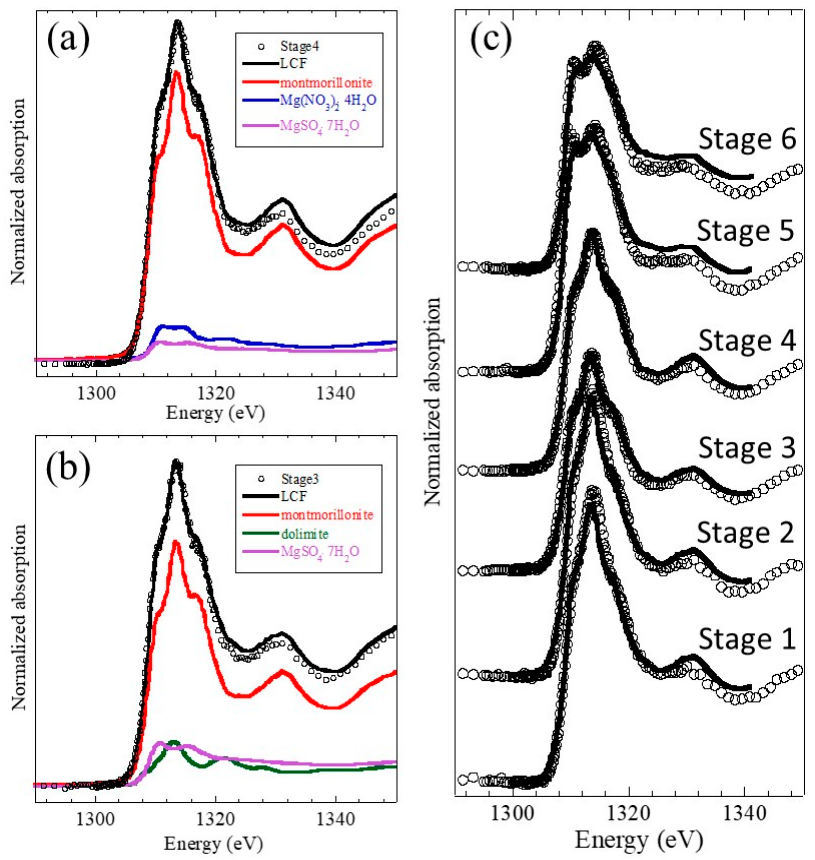
Figure 7. Mg K-edge XANES spectra for Mg in aerosol samples: ( a ) LCF for Mg in ( a ) Stage 4 and ( b ) Stage 3. ( c ) LCF results for XANES spectra of aerosol particles (circle: measured spectra; solid curve: fitted spectra).